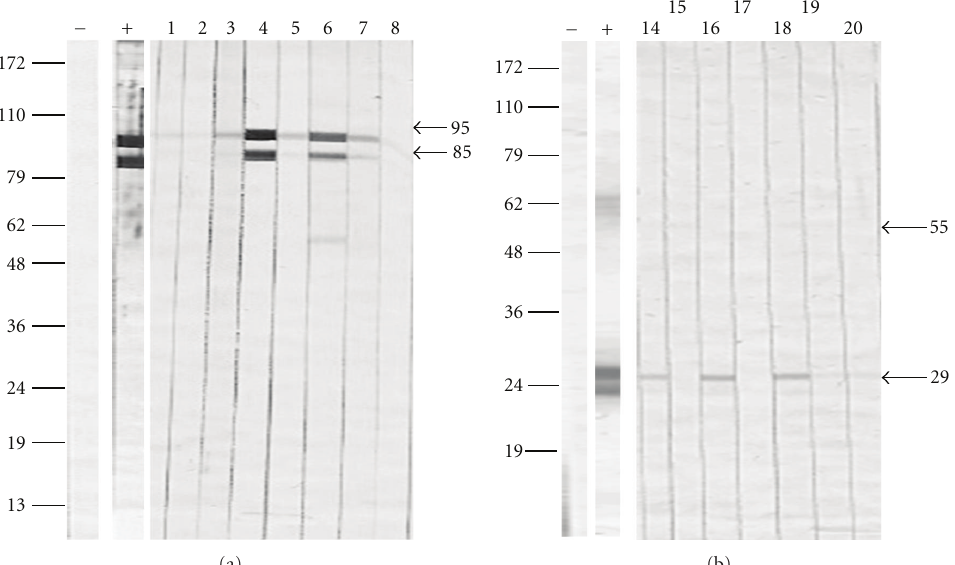
Figure 5: Western blot with AgB (a) and P29 (b) recombinants from Taenia solium was incubated with 33 hamster sera infected with T. solium tapeworms. Preimmune hamster normal sera (lane − ) were used as negative controls. Hyperimmune anti-AgB and anti-P29 from T. solium sera from hamster were used as positive controls (lanes +). WB shows representative samples of the assay. Number of lanes is corresponding to serum number of the assay.